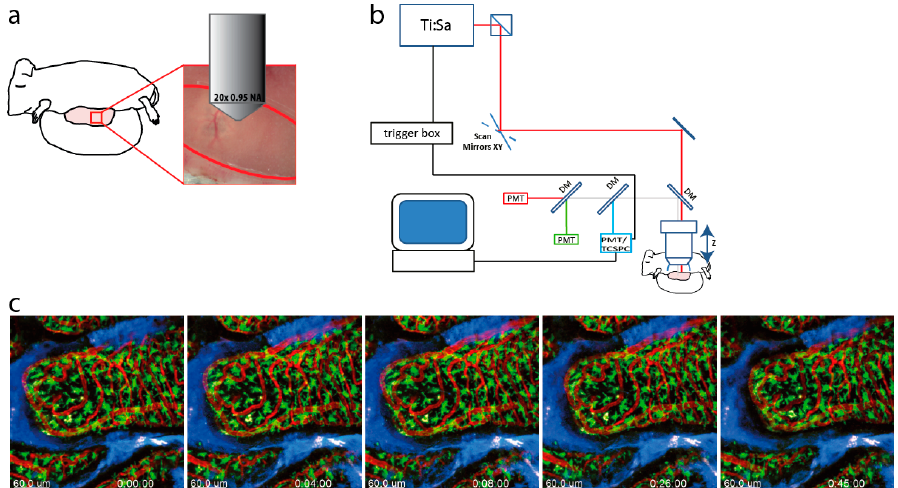
Figure 1. Intravital multi-photon fluorescence microscopy of the small intestine ( a ) Small intestine preparation for imaging: the small intestine of a mouse was exteriorized, its wall was carefully cut to avoid bleeding, placed on a heated stage for imaging and fixed by a thin layer of low-melting agarose. In this way intestinal villi were exposed and made accessible to the microscope objective lens. ( b ) Experimental setup: the beam of a 80 MHz pulsed titanium sapphire laser (Ti:Sa) at 760 nm is scanned objective. Excitation and emission light are separated by a dichroic mirror (cut off 695 nm), the emission